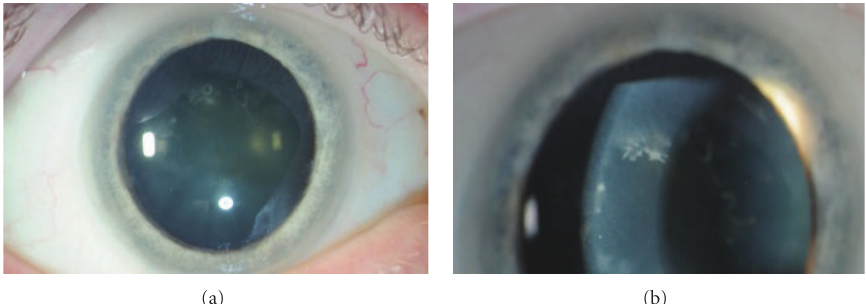
Figure 3: Photographs 17 months after initial presentation demonstrating fading of the endothelial crystalline deposits in the right eye